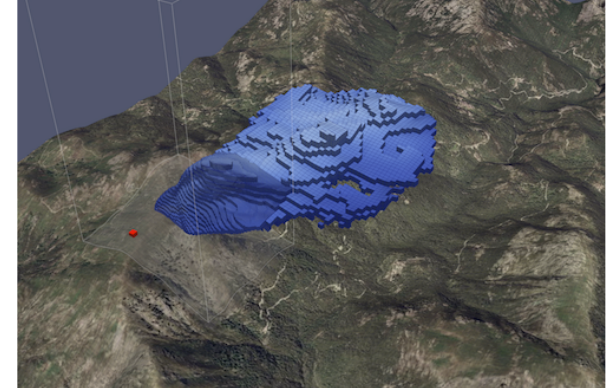
Fig. 7. Simulated smoke tracer in the large and nested domain at t : 1000s. Lidar location is shown in